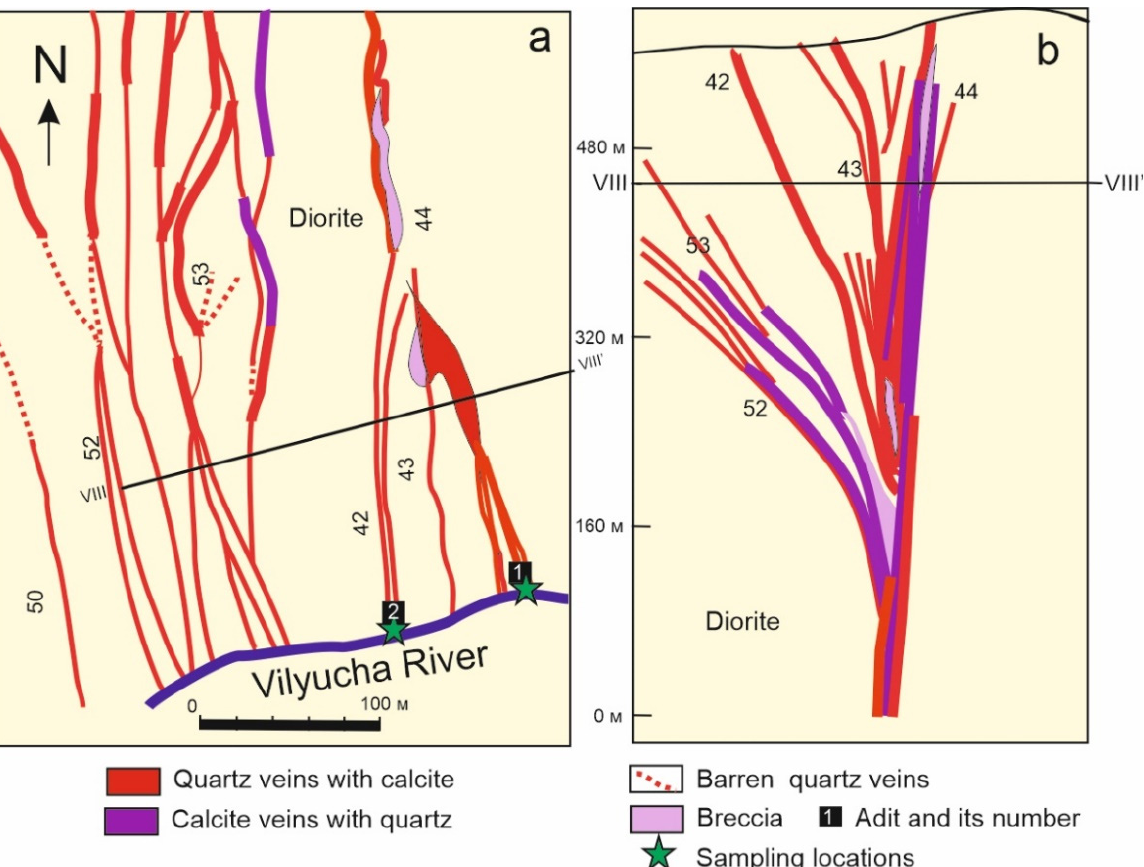
Figure 2. Geological scheme of the Rodnikovoe deposit ( a ) and cross section VIII-VIII’ ( b ) modified after [3,6,10]. The numbers correspond to the numbers of mineralized veins; the vertical scale indicates the height above mean sea level in meters.